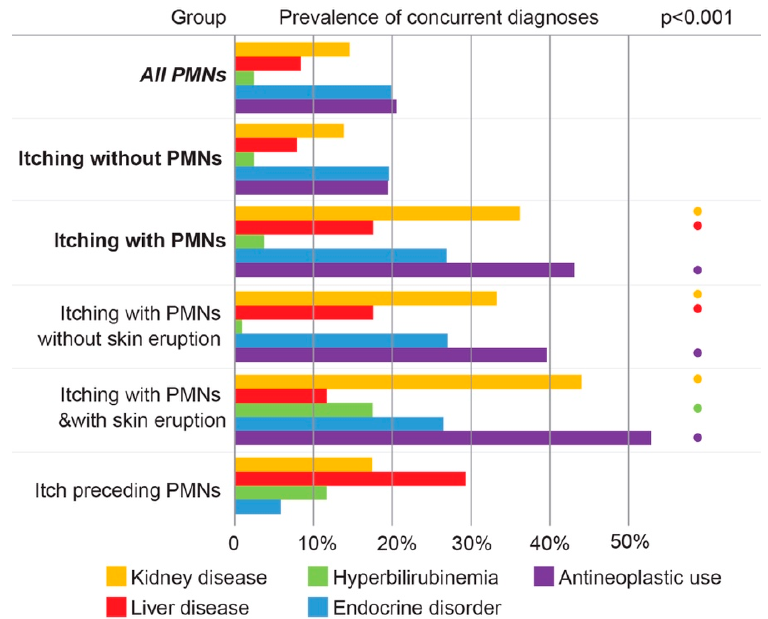
Figure 4. Pruritus among pediatric cancer patients is associated with comorbidities. Percentages of each group with concurrent diagnoses of kidney disease (gold), liver disease (red), hyperbilirubinemia (green), antineoplastic use (purple), and endocrine disorders (blue). • denotes statistically significant difference in comorbidity prevalence compared to pediatric patients with a primary malignant neoplasm (PMN) but without itch ( p < 0.01).